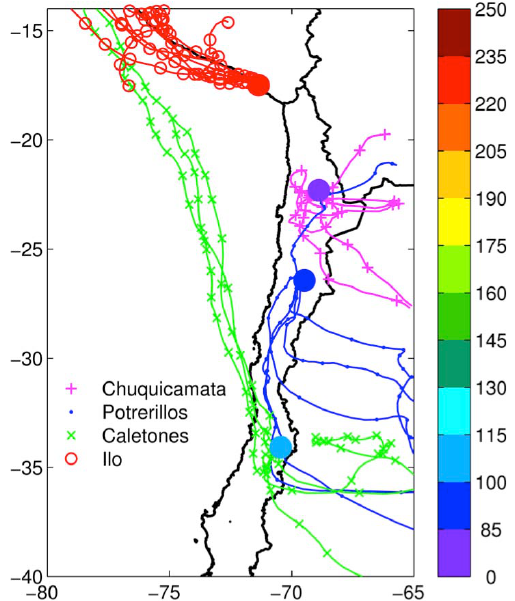
Fig. 5. Forward trajectories starting at major smelters that could po- tentially affect the VOCALS region. Trajectories are 5 days long during the VOCALS intensive period, starting every 5 days. Mark- ers are plotted every 6 h. Symbols represent different major smelter locations, with colors portraying the sulfur emissions of each (as- sumed to be emitted as SO 2 ) in Ggyr − 1 .